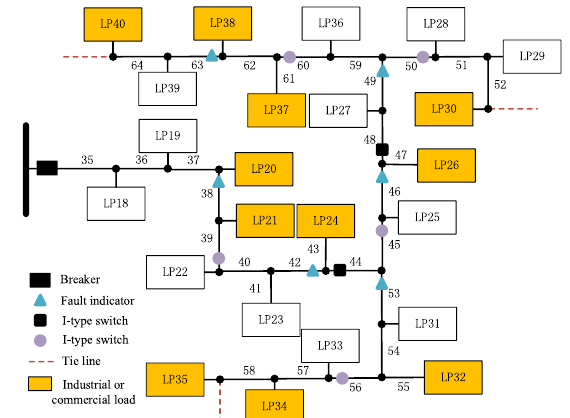
Fig. 5 Optimal layout results of scenario